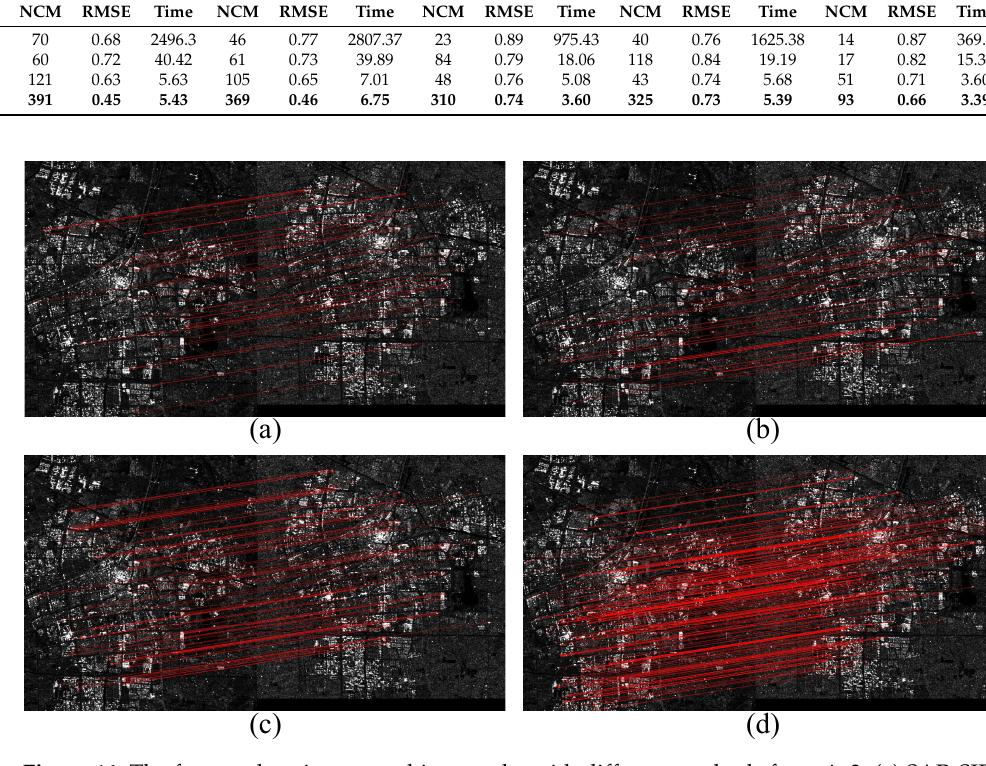
Figure 14. The feature descriptor matching results with different methods for pair 3. ( a ) SAR-SIFT. ( b ) SOSNet. ( c ) Sim-CSPNet. ( d ) Our proposed